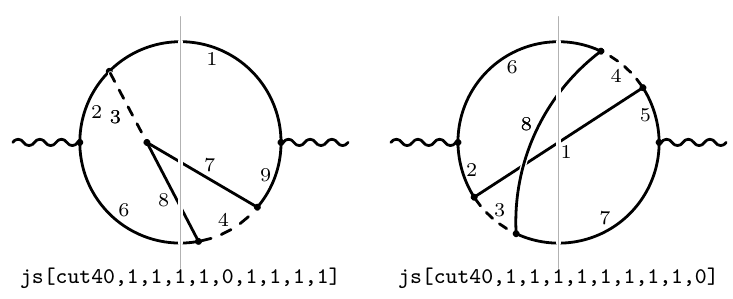
Figure 5 . Prototypes for master integrals of (4 , 0)